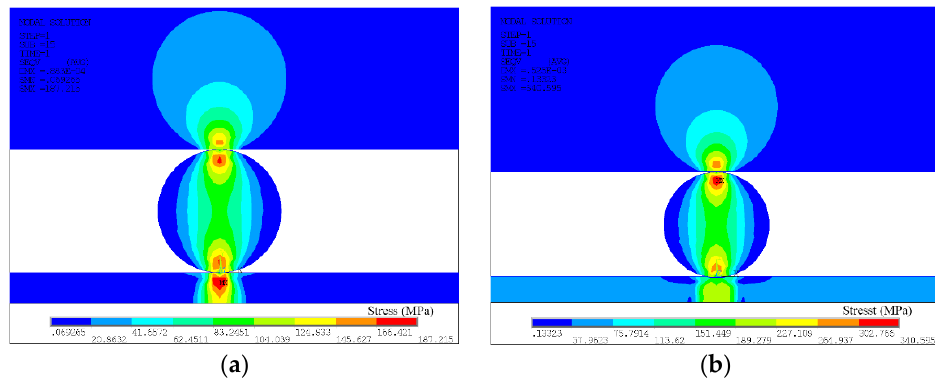
Figure 10. Stress distribution of the von Mises stress: ( a ) F = 0.2 N and ( b ) F = 0.5 N.